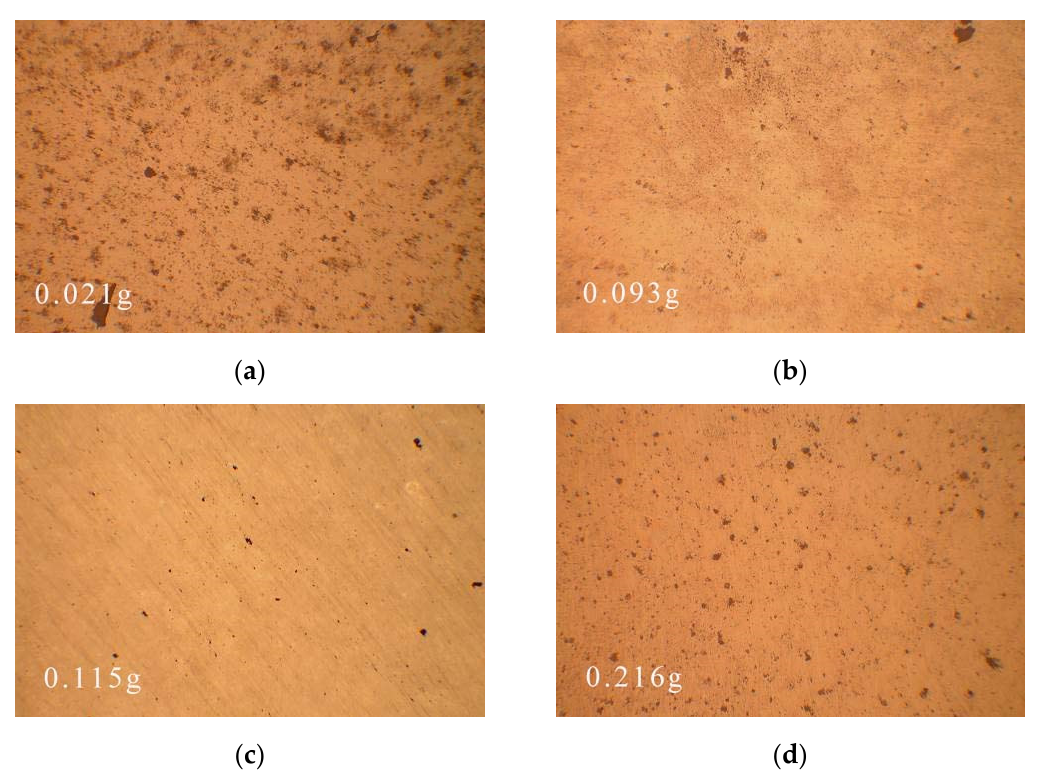
Figure 13. Cleaning effect of samples with different water contents observed by a metallographic microscope: ( a ) 0.021 g; ( b ) 0.093 g; ( c ) 0.115 g; ( d ) 0.216 g.